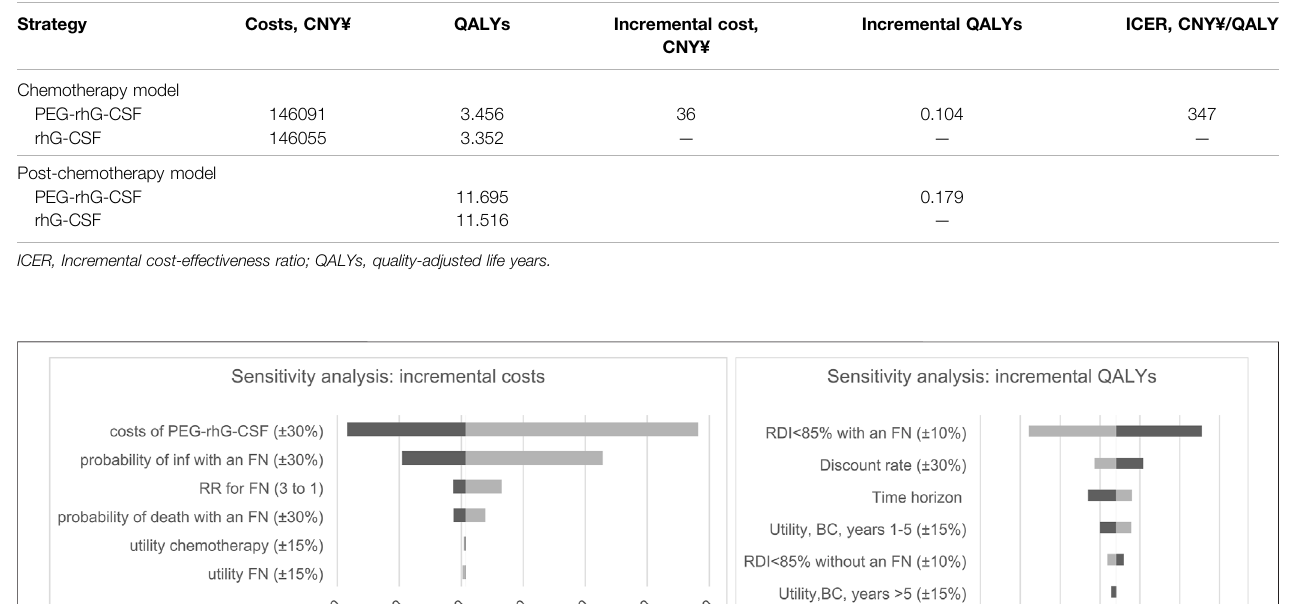
Frontiers in Pharmacology |